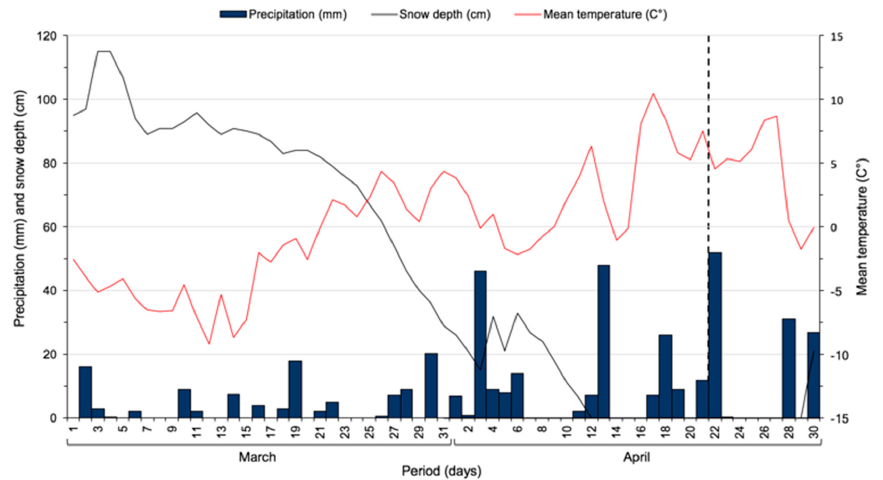
Figure 14. Precipitation (in blue), snow depth (in black) and daily temperature (in red) recorded at the Ak-Terek weather station for the months of March and April 2017. The dotted line represents the moment when Koytash was